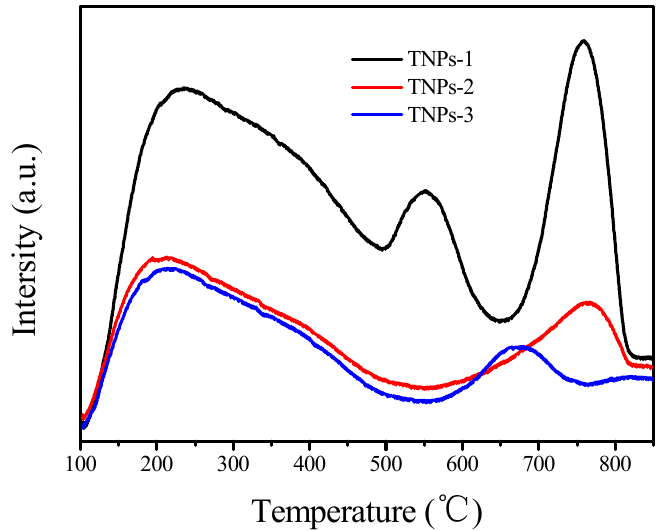
Figure 4. The NH 3 -TPD profiles of TNPs-1, TNPs-2, and TNPs-3.